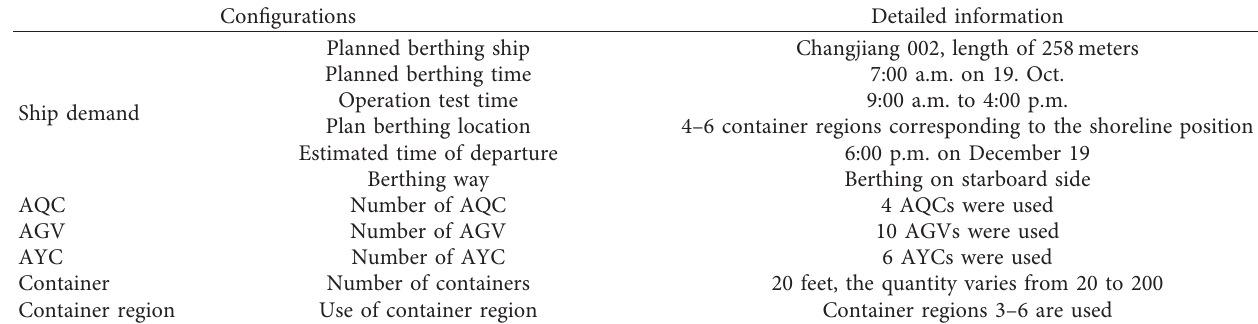
Figure 6: The system structure and operation process of the terminal. Table 1: Parameter setting for the operation of